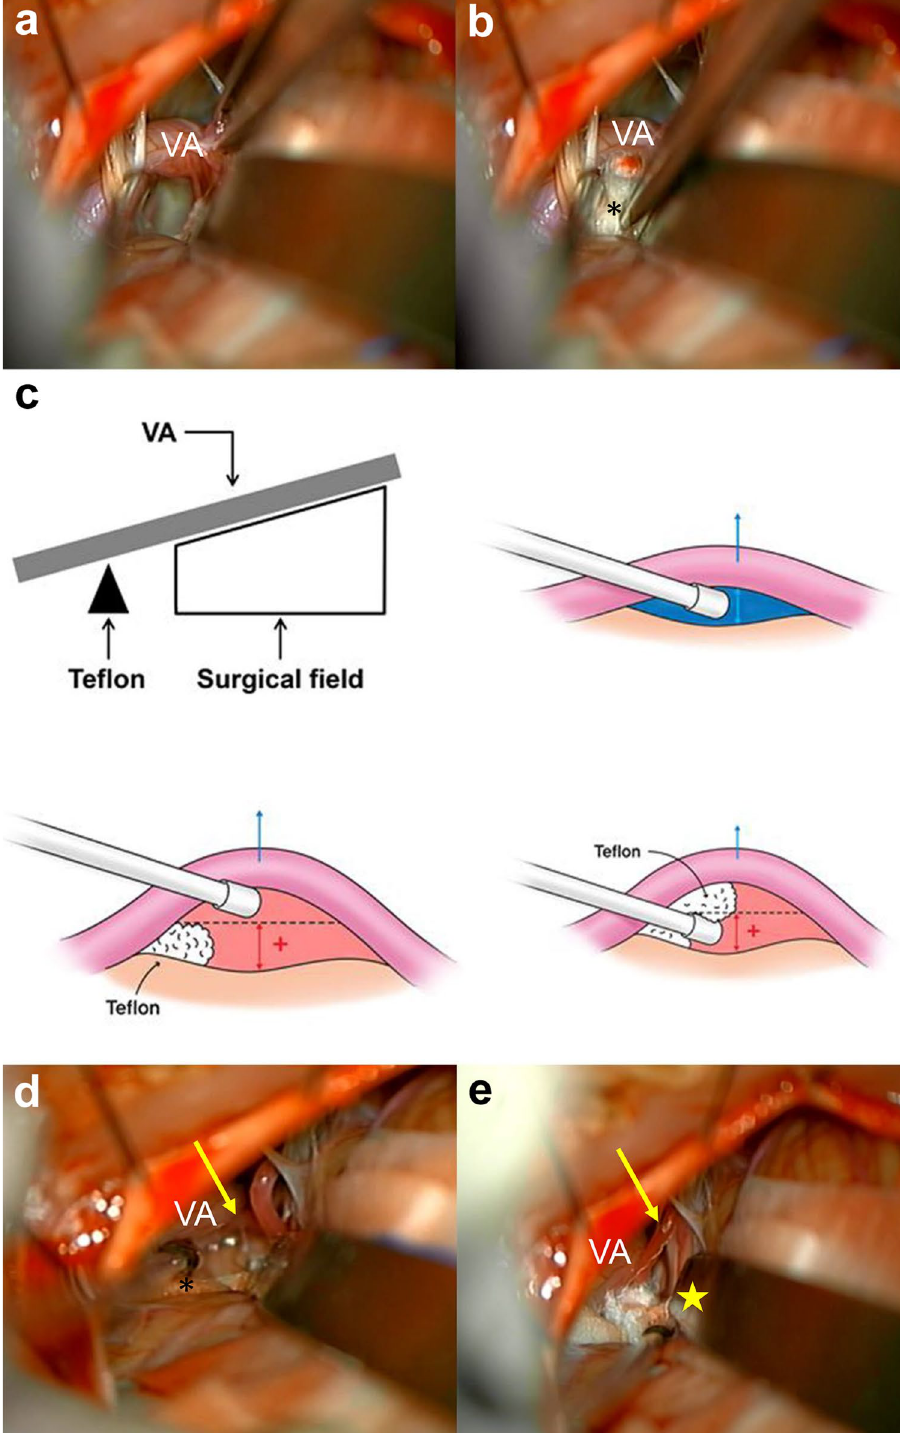
Figure 1. Step-by-step intraoperative photographs during microvascular decompression (MVD) for vertebral artery (VA)- involved hemifacial spasm with an illustration of the Teflon Fulcrum method. ( a ) Attempts to lift the VA high enough toward the petrous bone to expose the root exit zone using a suction tip failed. ( b ) Teflon felt (*) is placed between the proximal VA and ventromedial brainstem near the lower cranial nerves. ( c ) The inserted piece of Teflon works as a fulcrum, and the VA could be elevated away from the brainstem and maintained at the height of Teflon’s thickness. This allowed larger surgical space by either moving the VA distal to the fulcrum or pushing the fulcrum together with the overlying VA. ( d ) The mobilized VA with the support of the Teflon fulcrum from underneath provides a wider view of the surgical field. ( e ) The co-offending vessel (arrow), the anterior inferior cerebellar artery, underneath the VA and the neurovascular compression site (star) could be visualized by slightly adjusting the angle of microscope. Complete MVD was achieved by inserting one or two more Teflon felts. MVD microvascular decompression, VA vertebral